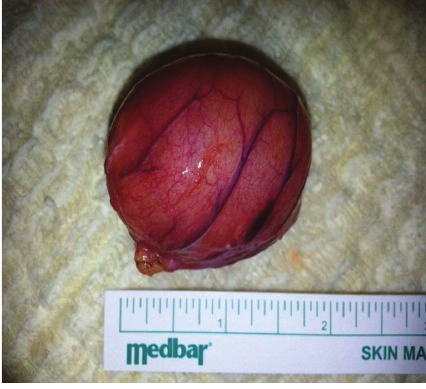
Figure 3: The appearance of the mass.